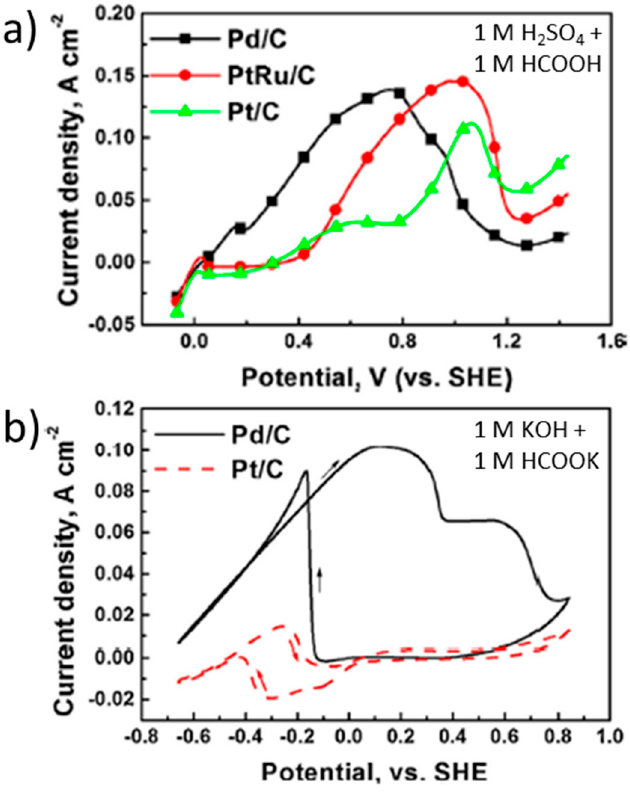
Figure 2. ( a ) Linear sweep voltammograms, at 20 mV s − 1 , of Pd/C, PtRu/C and Pt/C catalysts in 1 M HCOOH + 1 M H 2 SO 4 , ( b ) Cyclic voltammetry, at 20 mV s − 1 , of Pd/C and Pt/C catalysts in 1 M HCOOK + 1 M KOH. Reprinted with permission from Ref. [70].